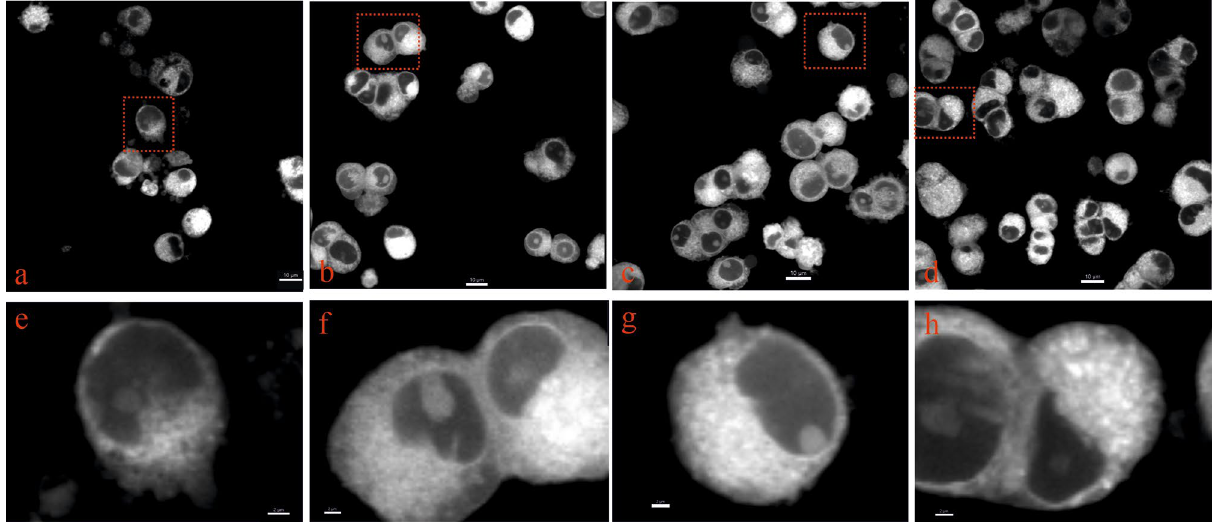
Figure 3. Changes in mitochondrial morphology in glutamate-exposed PC-12 cells are prevented by ADA- 409-052. MitoTracker Red CMXRos was used to stain mitochondria of PC-12 cells after 24 h of exposure to (a,e) 20 mM glutamate, (b,f) glutamate and 10 µM ADA-409-502, or (c,g) ADA-409-052 only, plus control ( d,h ; media only). ( b–d,f–h ) Cells, exposed to ADA-409-052 in absence or presence of glutamate show a similar distribution and density of MitoTracker Red CMXRos-positive structures as control cells. ( a,e ) However, in glutamate-exposed cells appear distribution and density altered, and the overall number of viable cells reduced. Mitochondria were detected by confocal microscopy in live cells and magnified images ( e–h ) were produced using Imaris; red boxes indicate magnifications. Scale bar: 10 µm; 2 µm for